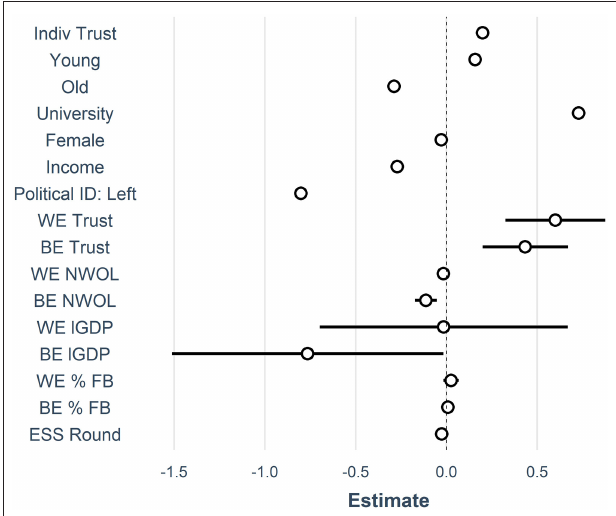
FIGURE 4 | Dot and whisker plot of effect sizes on anti-immigrant attitudes.